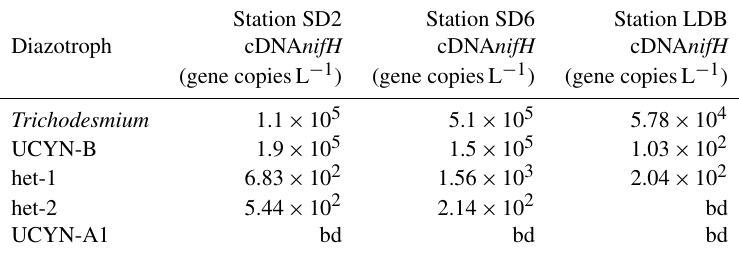
Table 4. Summary of nifH gene expression data determined by qRT-PCR at selected stations (SD2, SD6, LDB), where the cell-specific N 2 fixation rates were